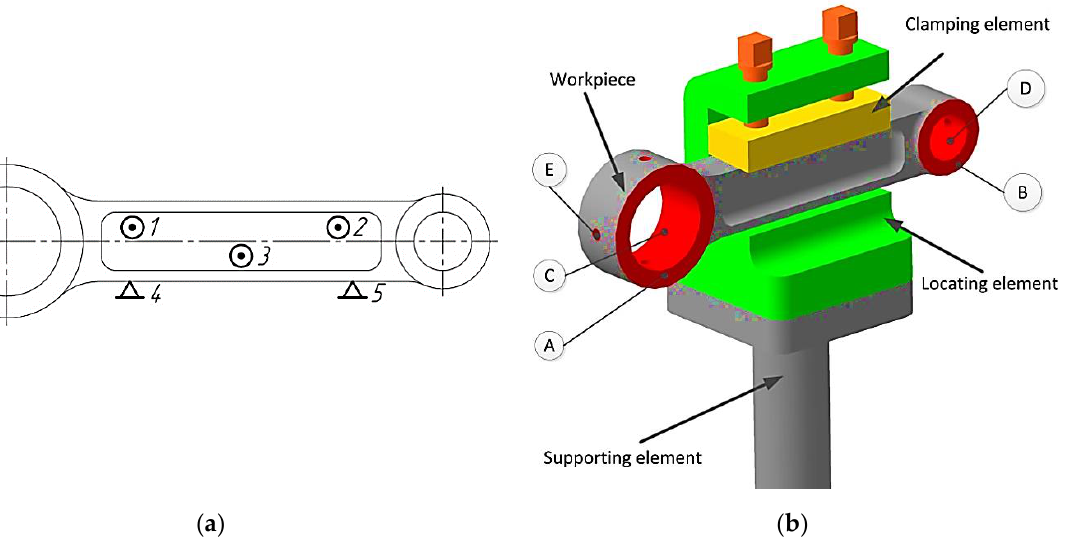
Figure 3. Flexible fixture for machining a one-piece connecting rod with machined surfaces in a CNC multi-purpose operation: ( a ) Locating chart; ( b ) 3D visualization.